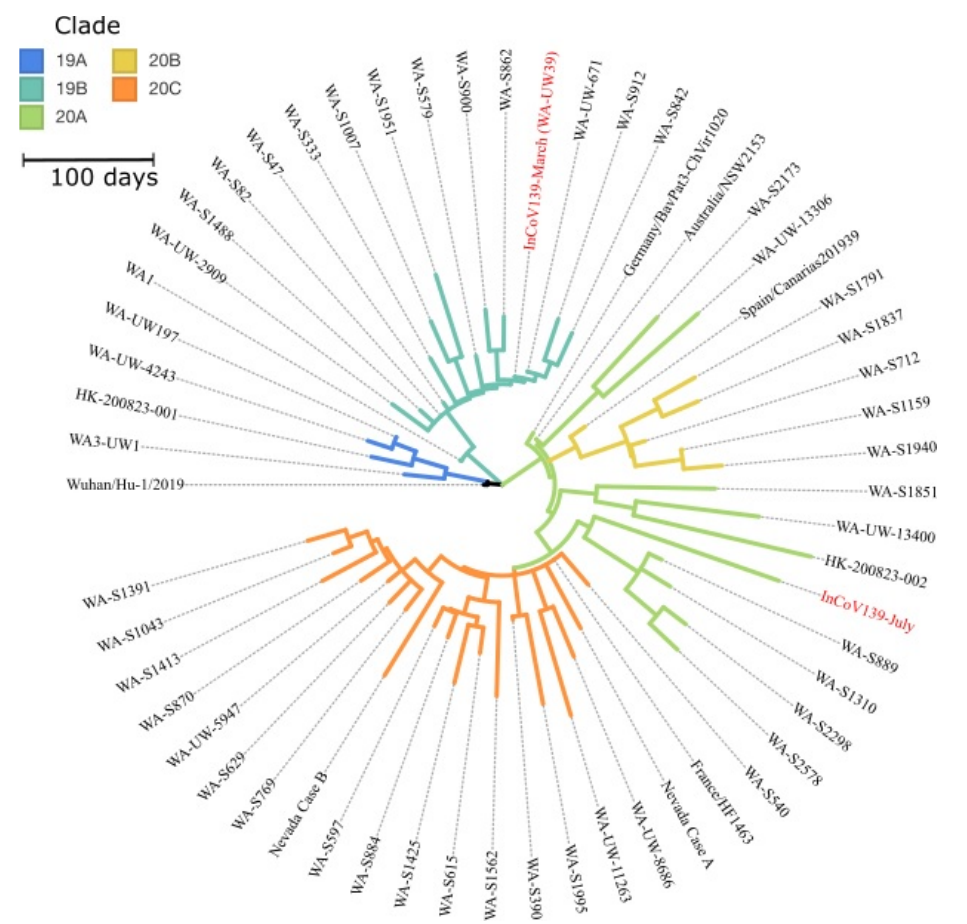
Figure 2. Phylogram of SARS-CoV-2 Isolates in Washington State. A phylogeny of SARS-CoV-2 in Washington State demonstrates that the primary and reinfection strains are distinct. The figure also includes contextual sequences illustrating clade roots and the pairs of reinfection cases from Hong Kong and Nevada. The pair of reinfection samples from InCoV139 (red) type to clade 19B from the primary infection in March and to clade 20A from the reinfection in July. The initial Hong Kong sample was in Clade 19A and the reinfection sample in 20A; both Nevada samples were in Clade 20C. Sequences labels follow abbreviated GISAID nomenclature, and further sequence information is provided (Table S2). An interactive version of this tree is included as supplemental material.